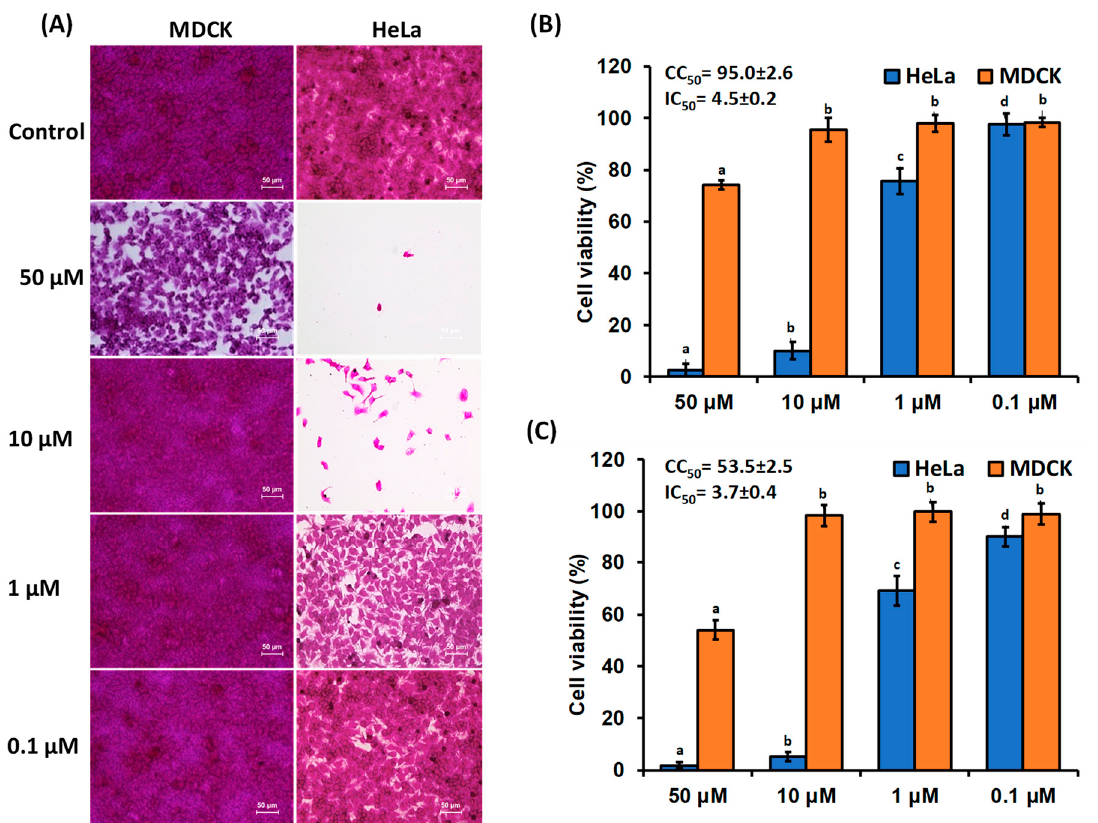
Figure 2. The effects of β -cryptoxanthin treatments on the proliferation of the normal Madin-Darby Canine Kidney (MDCK) and human cervical carcinoma (HeLa) cells. The dose of 0.1–50 µM of β -cryptoxanthin were used to treat MDCK and HeLa cells. ( A ) Analysis of morphological changes of normal MDCK and HeLa cells, documented after 48 h of incubation using light microscopy. The normal MDCK and HeLa cells viability after ( B ) 24 and ( C ) 48 h of incubation. The IC 50 and CC 50 indicate the 50% inhibition concentration of HeLa cell and 50% cytotoxic concentration of MDCK cells, respectively. All data are reported as mean values ± SD from independent experiments ( n = 3). The means accompanied by di ff erent alphabets (e.g., a, b, c, and d) are significantly di ff erent at p < 0.05. Scale bar, 50 µm.